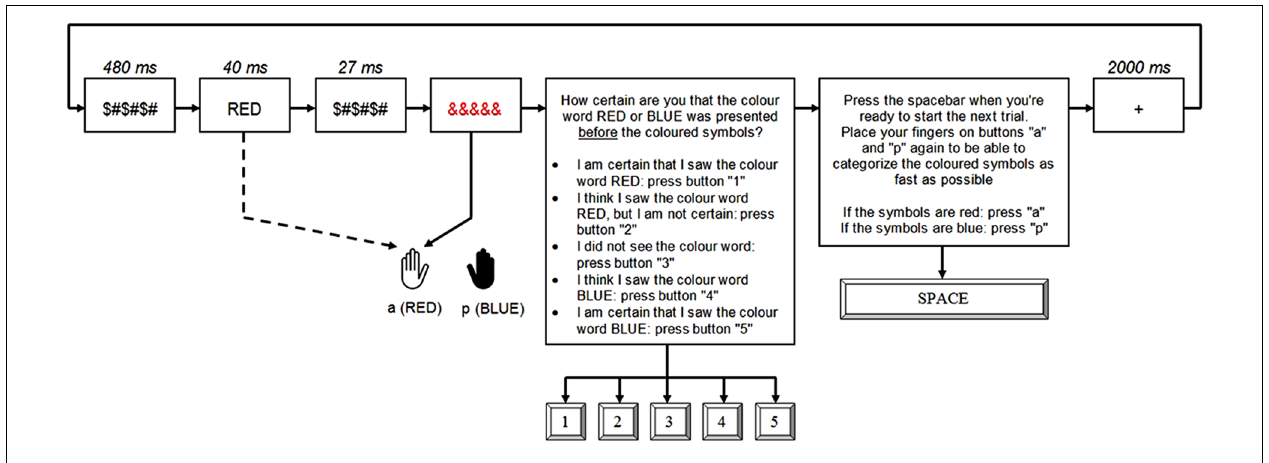
FIGURE 1 | Example of a congruent